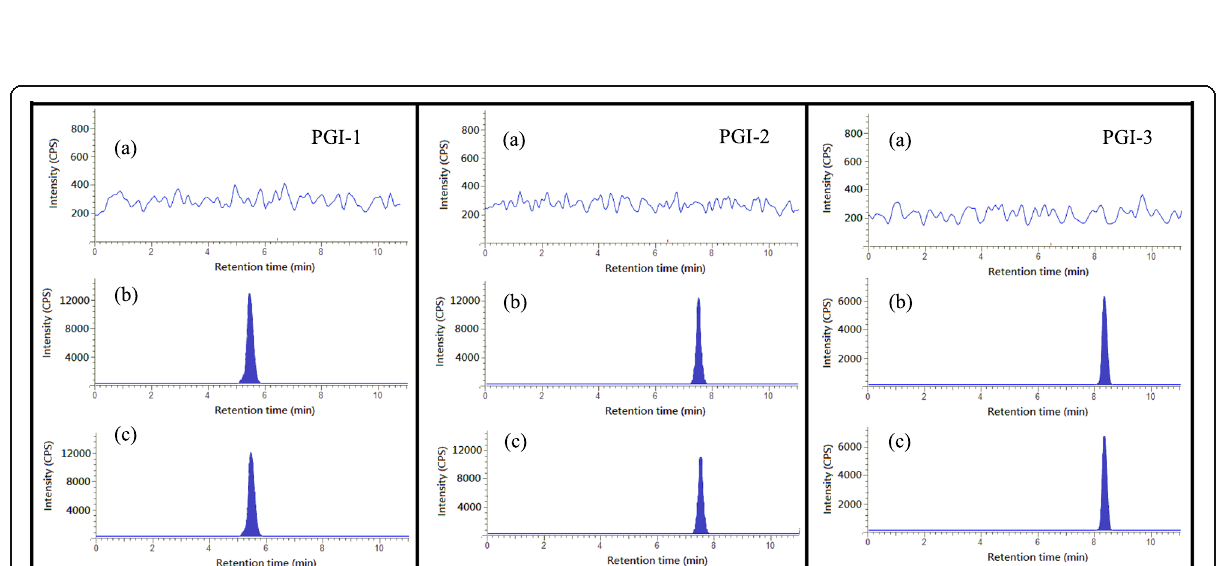
Fig. 4 MRM chromatograms of PGI-1, PGI-2, and PGI-3. a Blank. b Un-spiked PGI standard at 50 ppm. c PGI standard at 50 ppm spiked with